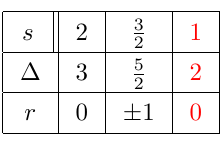
Table 1 . Spin s , conformal dimension ∆ , and R-charge r of the operators in the